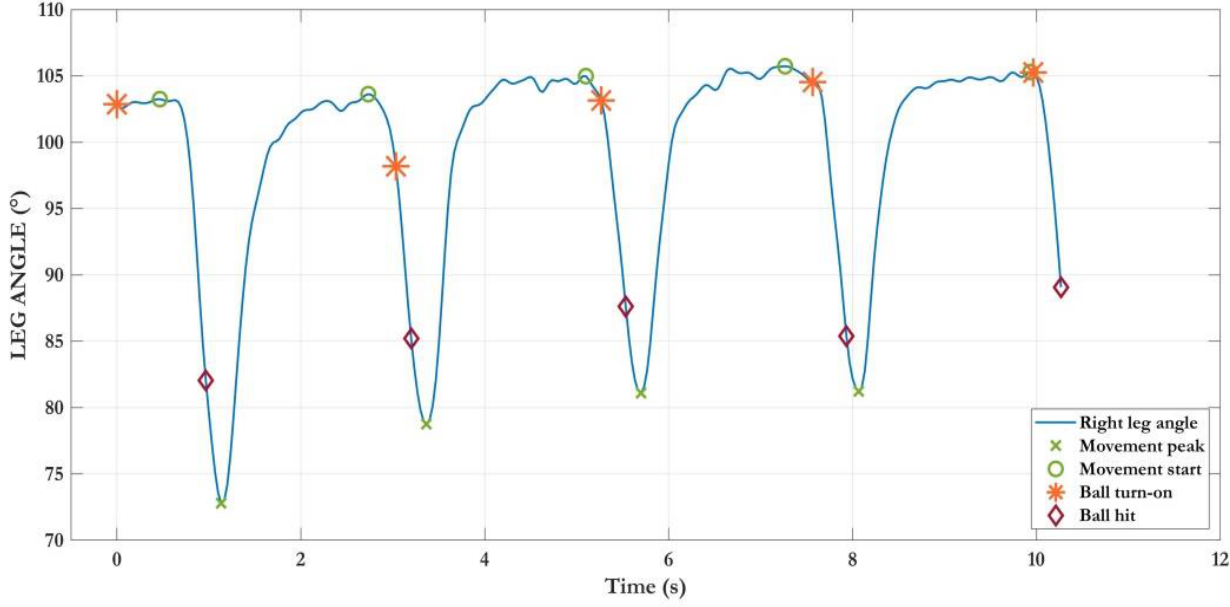
Figure 6. Example of the trajectory of right leg angle during the first subtask of Bouncing Ball exergame. The subject eventually learns to wait for ball light-ons before starting to move (green circles approaching orange stars in the last movements).